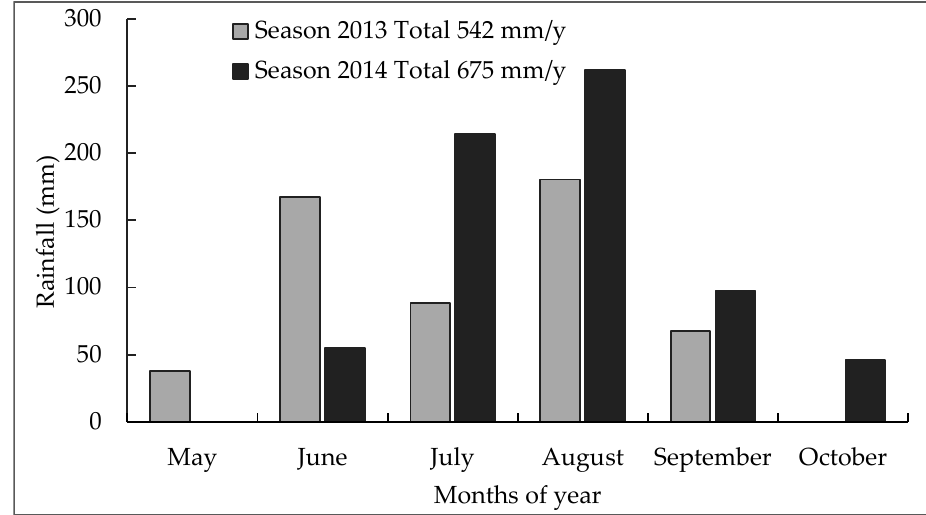
Figure 2. The distribution of the rainwater per month (mm/m) and the accumulation of rainfall in each of the growing seasons, Season 1 (2013) and Season 2 (2014).